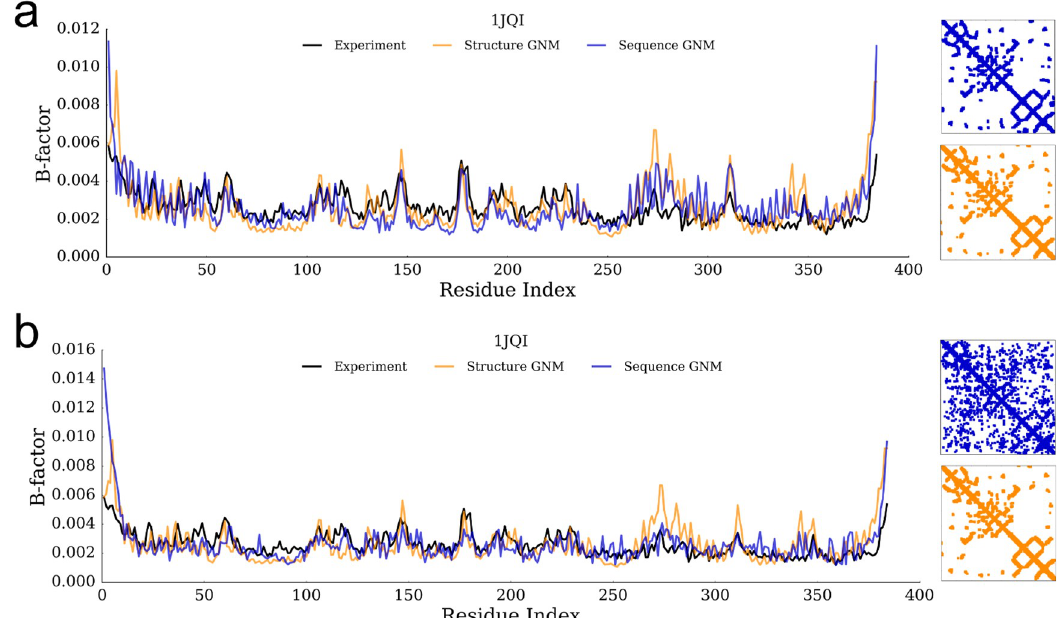
Fig 1. B-factors plots. A plot of theoretical B-factors as calculated by Seq-GNM (blue), the original GNM obtained from structure (orange), and observed experimental B-factors (black) for acyl-CoA dehydrogenase (PDB id: 1JQI) along with predicted contact maps by Seq-GNM (using a threshold score, shown as blue) and the contact map of the structure (using 10 Å cut-off distance) (a) The Seq-GNM with values obtained from RaptorX produces a correlation of 0.56 with experiment, and 0.77 with the GNM obtained from structure. Moreover, the contact maps reveal that the predicted contacts between the Seq-GNM and structural GNM approaches are remarkably similar. (b) The Seq-GNM that uses values obtained from EVcouplings produces a correlation of 0.60 with experiment, and 0.68 with the GNM obtained from structure. The B-factor obtained by applying GNM to the experimental structure yields a correlation of 0.57. The contact map captures the dominant contacts with noise coming from poorly predicted EVcouplings